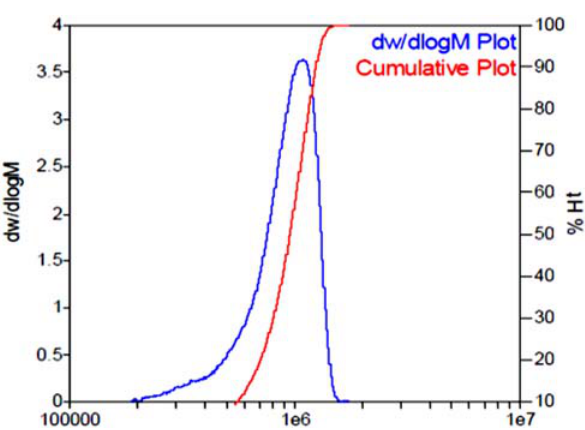
Figure 3: Molecular weight distribution of PDAA determined by